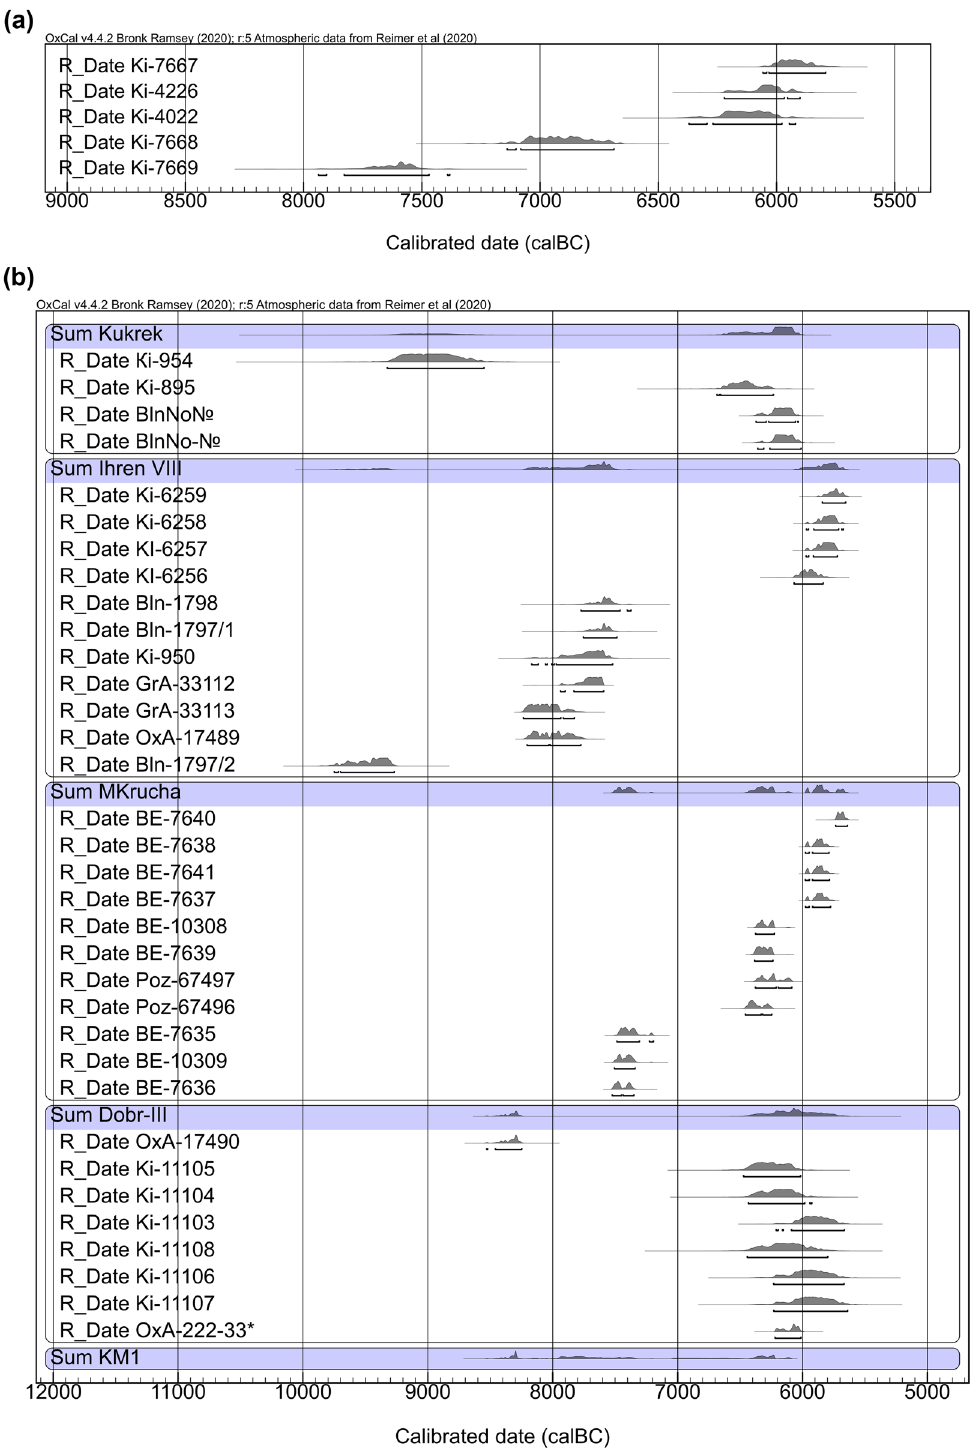
Figure 8: ( a ) Conventional dates for the Kamyana Mohyla 1 site ( after Kotova, 2003; Telegin, 1990 ) ; ( b ) Sum of dates for Mesolithic layers of the Kamyana Mohyla 1 ( KM1 ) site and relevant dates of Kukrek sites ( after Kiosak et al., 2021; Kotova, 2003; Lillie et al., 2009; Telegin, 2002; Zaliznyak et al., 2013 ) from North Pontic region. Dobr - III – Dobrianka III, MKrucha – Melnychna